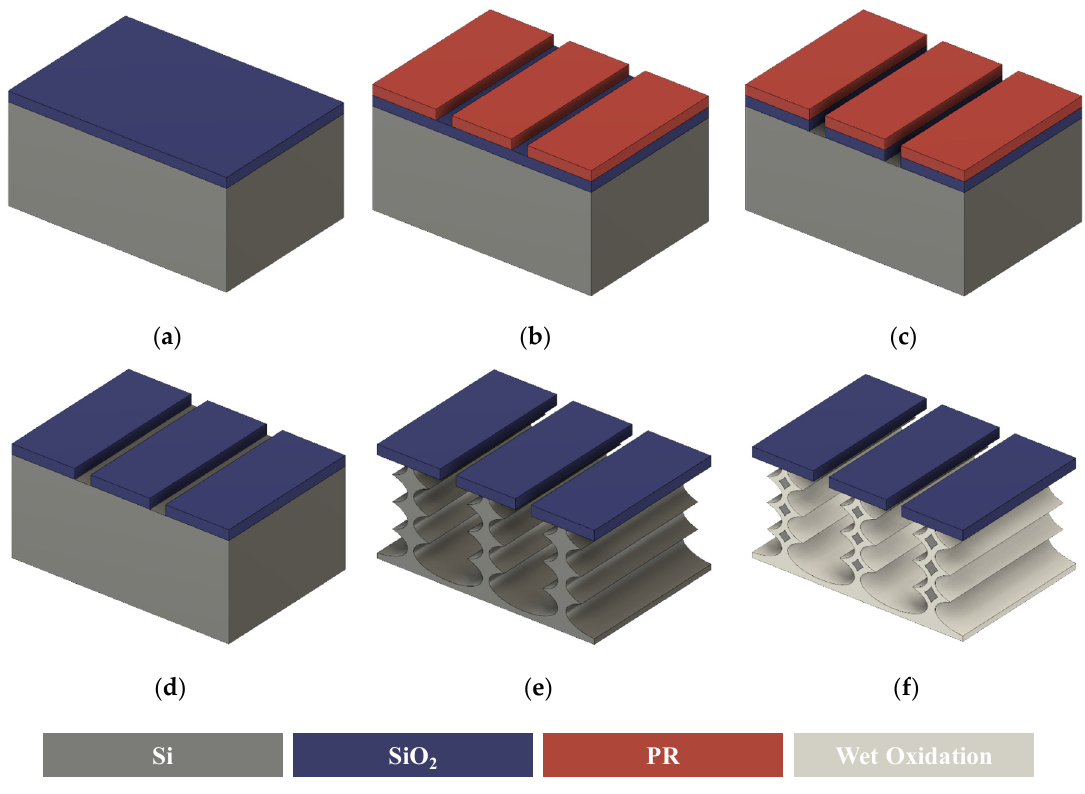
Figure 2. Fabrication process flow. ( a ) TEOS deposition; ( b ) PR patterning using UV lithography; ( c ) TEOS patterning; ( d ) PR removal; ( e ) DRIE for fabricating protrusion and support structure; ( f ) wet oxidation for nanowire fabrication and layer-to-layer isolation. Table 1. DRIE process steps for process development.